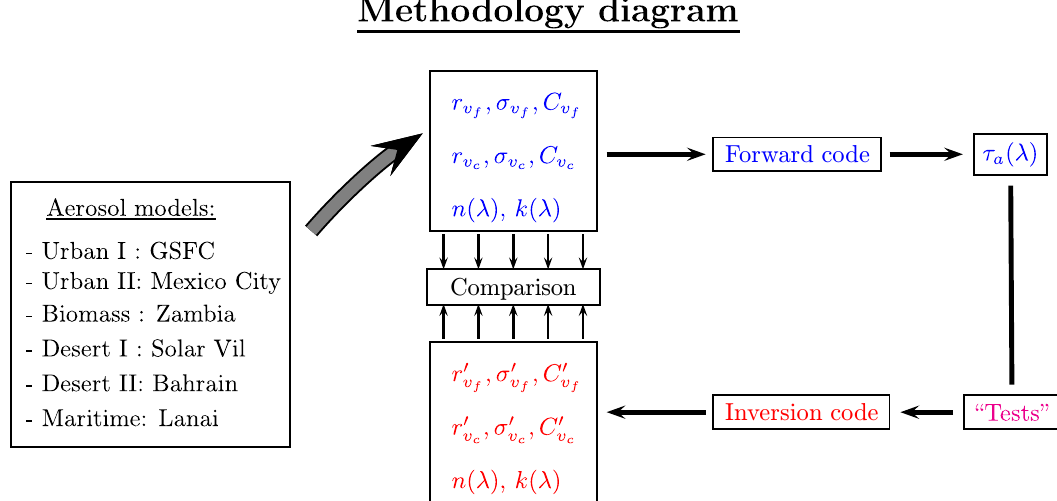
Figure 3. Methodology diagram followed to carry out different sensitivity “tests” on GRASP-AOD